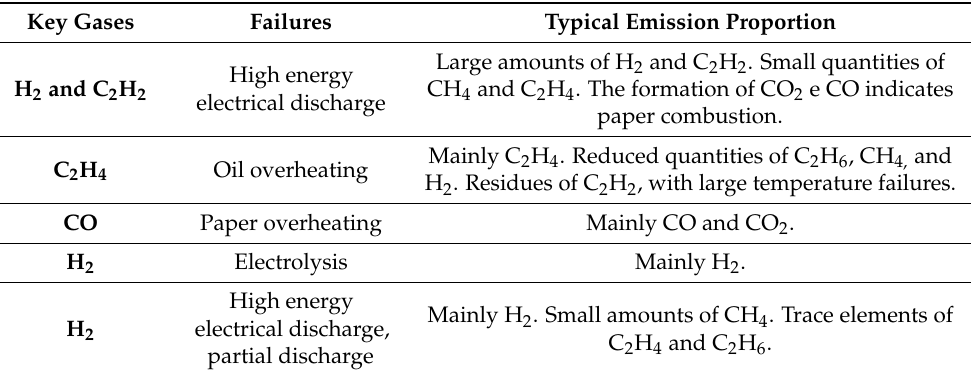
Table 5. Key Gas Method—Key gases and associated failures (adapted from